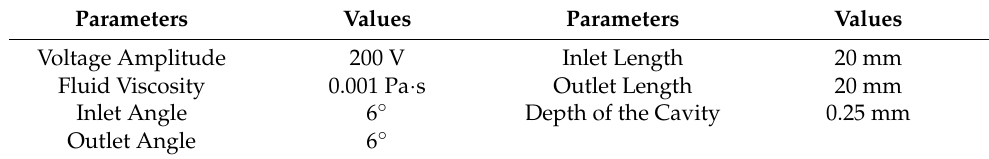
Table 1. Initial values of each parameter.